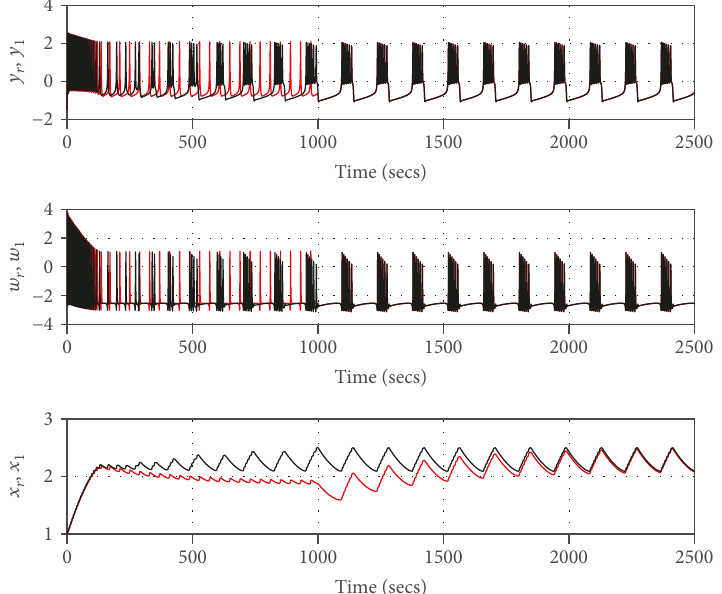
Figure 4: Behavior of state variables of the Σ